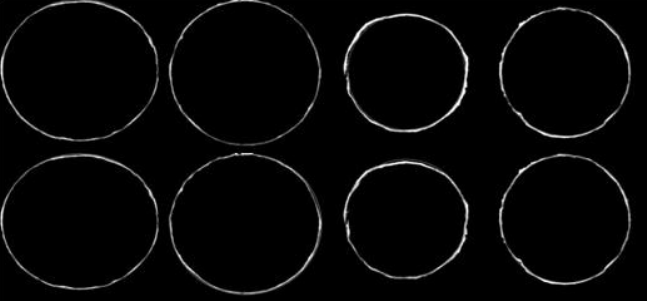
Figure 12. Comparison of the results.